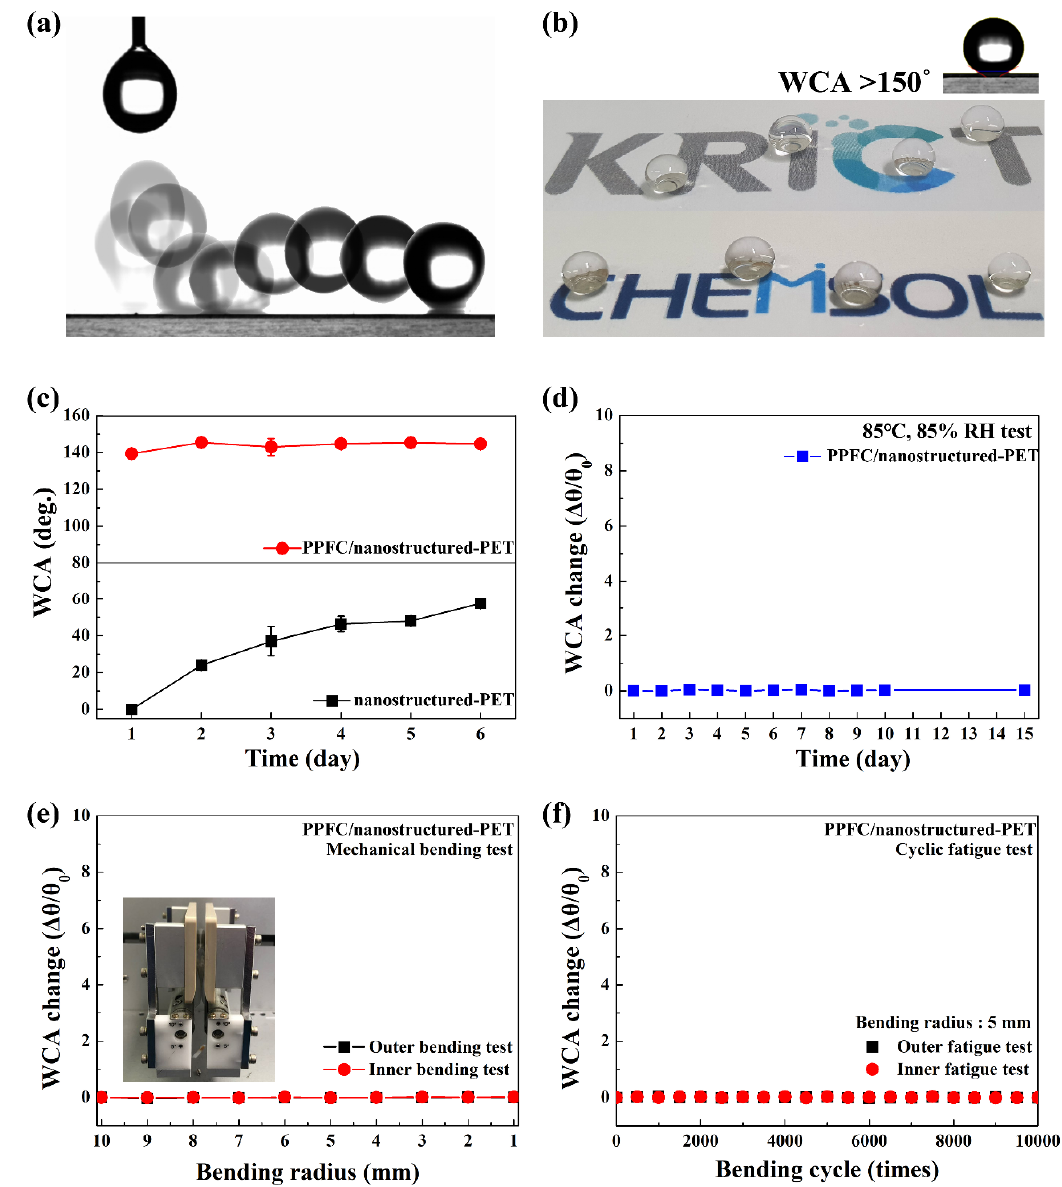
Figure 5. The superhydrophobic and durable characteristics of PPFC/nanostructured ‐ PET: (a) Image obtained from a video of water droplets falling on the surface, (b) image of water droplets on the PPFC/nanostructured ‐ PET surface, (c) aging effect and anti ‐ aging effect results obtained by measuring the WCA change over time, and (d) accelerated life test, (e) mechanical bending test, and (f) cyclic fatigue test of PPFC/nanostructured ‐ PET.